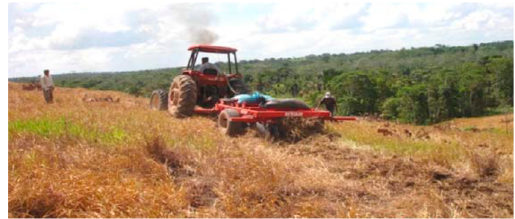
Figure 10. Offset disc ploughing of 1 m wide strips along the contour.